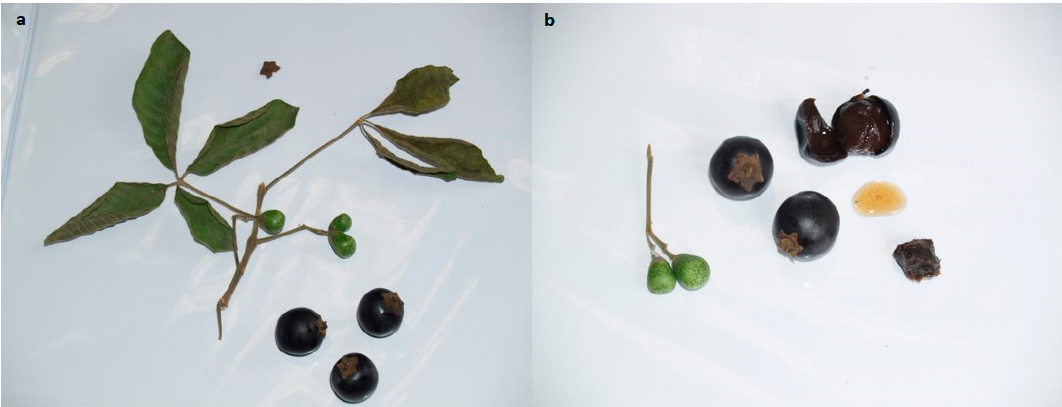
Figure 1. Pechiche fruit. ( a ) Pechiche plant leaves with ripe and unripe fruits. ( b ) Ripe and unripe fruits, epicarp and endocarp, seed and fruit juice.